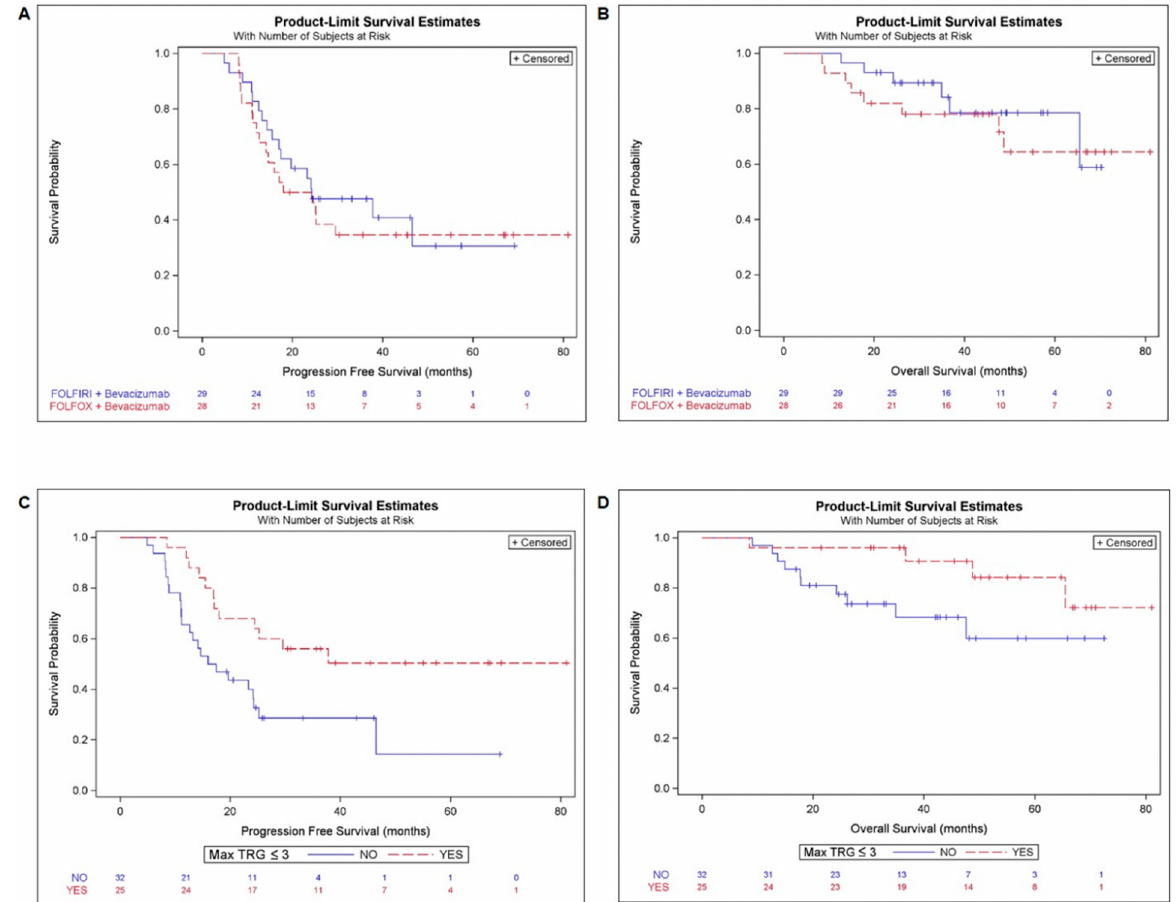
Figure 2. PFS and OS according treatment arm and max TRG ≤ 3. Kaplan-Meier curves for PFS ( A ) and OS ( B ) according to the treatment arm (mFOLFOX6-bevacizumab and FOLFIRI-bevacizumab). Kaplan-Meier curves for PFS ( C ) and OS ( D ) according to pathological response reflecting by Max- TRG ≤ 3 (yes/no). Independently of the treatment arm, the 25 (43%) patients with a max TRG ≤ 3 among resected CRLM (Max TRG ≤ 3; 43.8% of pts) had a significantly lower risk of relapse (PFS: